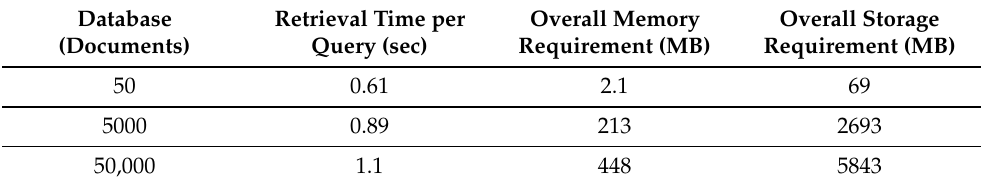
Table 3. Comparative evaluation results for different size